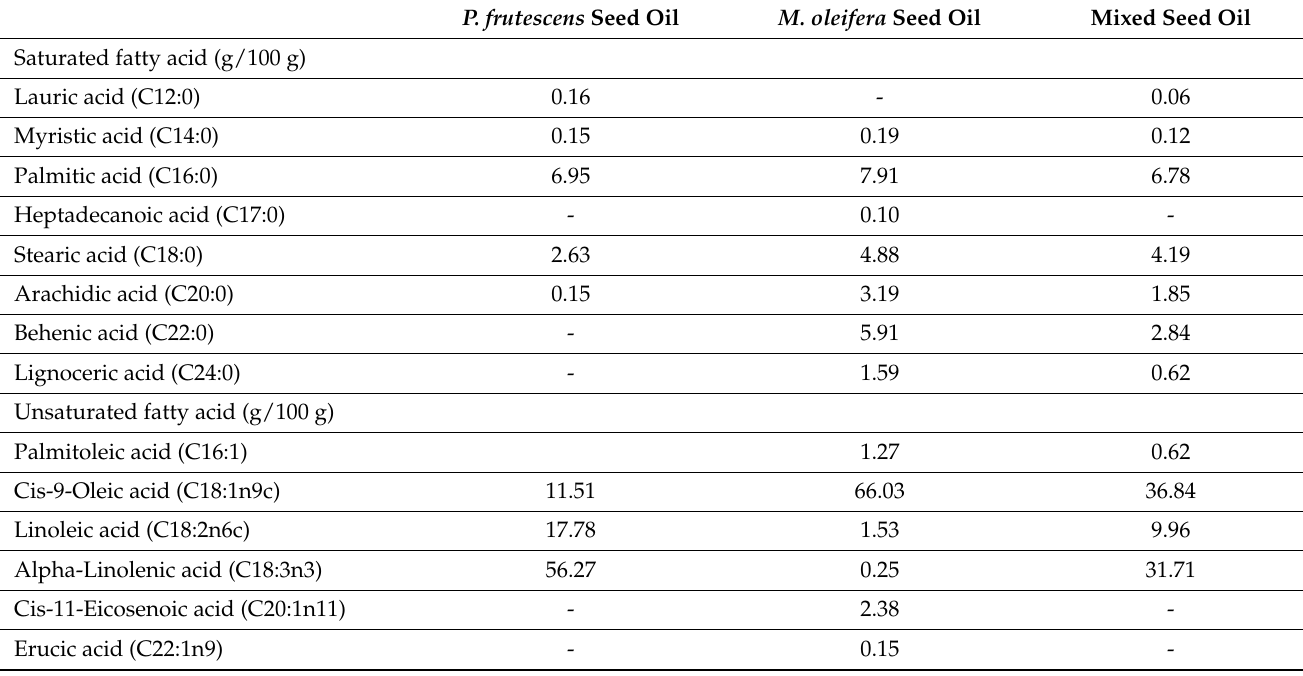
Table 2. Fatty acid composition of P. frutescens seed oil, M. oleifera seed oil, and mixed seed